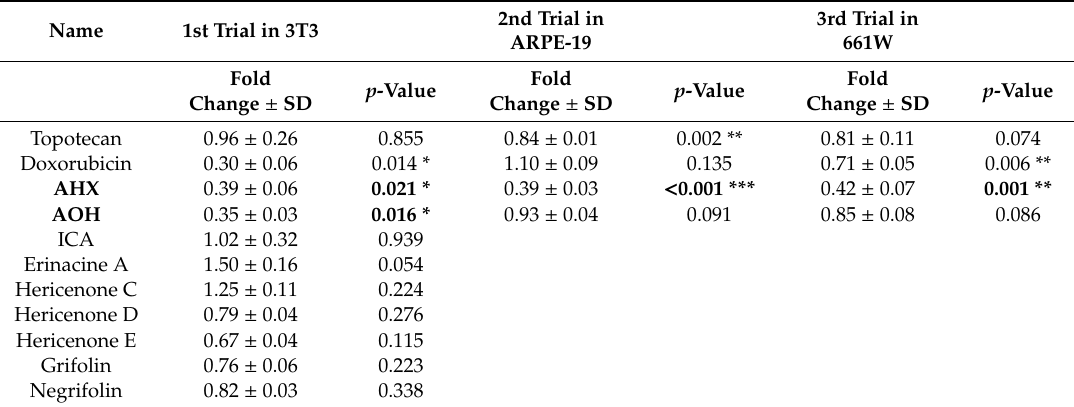
Table 2. Screenings of hypoxia-inducible factor (HIF) inhibitors from